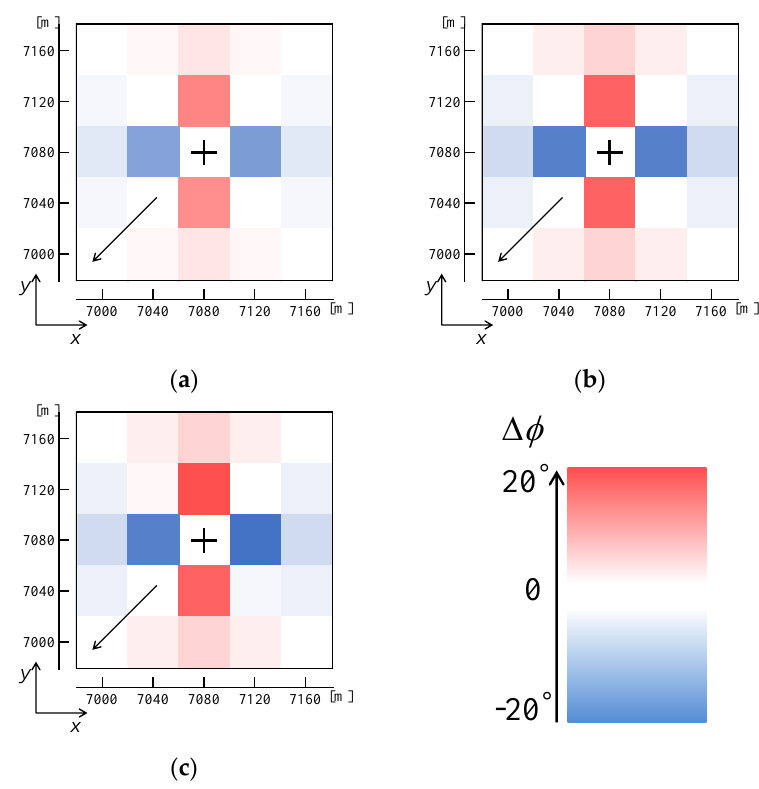
Figure 8. Color-coded azimuth error due to the presence of a nearby conducting structure having a height of 60 m and a square cross-section of 40 m × 40 m for the case of true azimuth φ equal to 45° and ground conductivity values equal to ( a ) 0.1 mS/m; ( b ) 5 mS/m; and ( c ) 1000 mS/m.